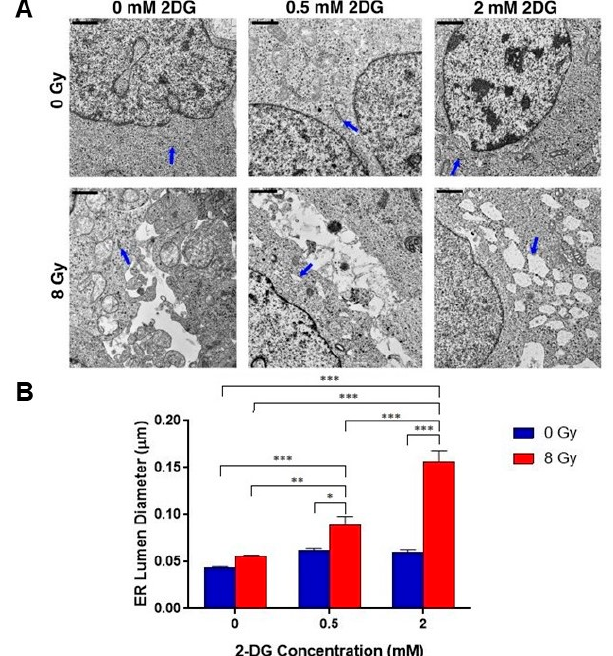
Figure 5. Combination radiotherapy and 2-DG increases ER dilation in GSCs. ( A ) Transmission electron microscopy (TEM) analysis of GSCs (Glio14 shown) comparing ultrastructural responses in non-treated lines and cells exposed to 8 Gy of radiation and/or increasing concentrations of 2-DG. Endoplasmic reticulum (ER) highlighted with blue arrows. Scale bar: 0.5 µm. ( B ) Quantitative analysis of ER luminal diameter, as a surrogate marker for ER stress, using TEM images (Glio14 shown). Results are representative averages of at least five images from two independent studies and are displayed as mean ± SEM. * p < 0.05, ** p < 0.01, *** p < 0.001. Mann-Whitney test. Table 2. ER diameter measurements in Glio14 treated with increasing doses of 2-DG and 8 Gy radiation.